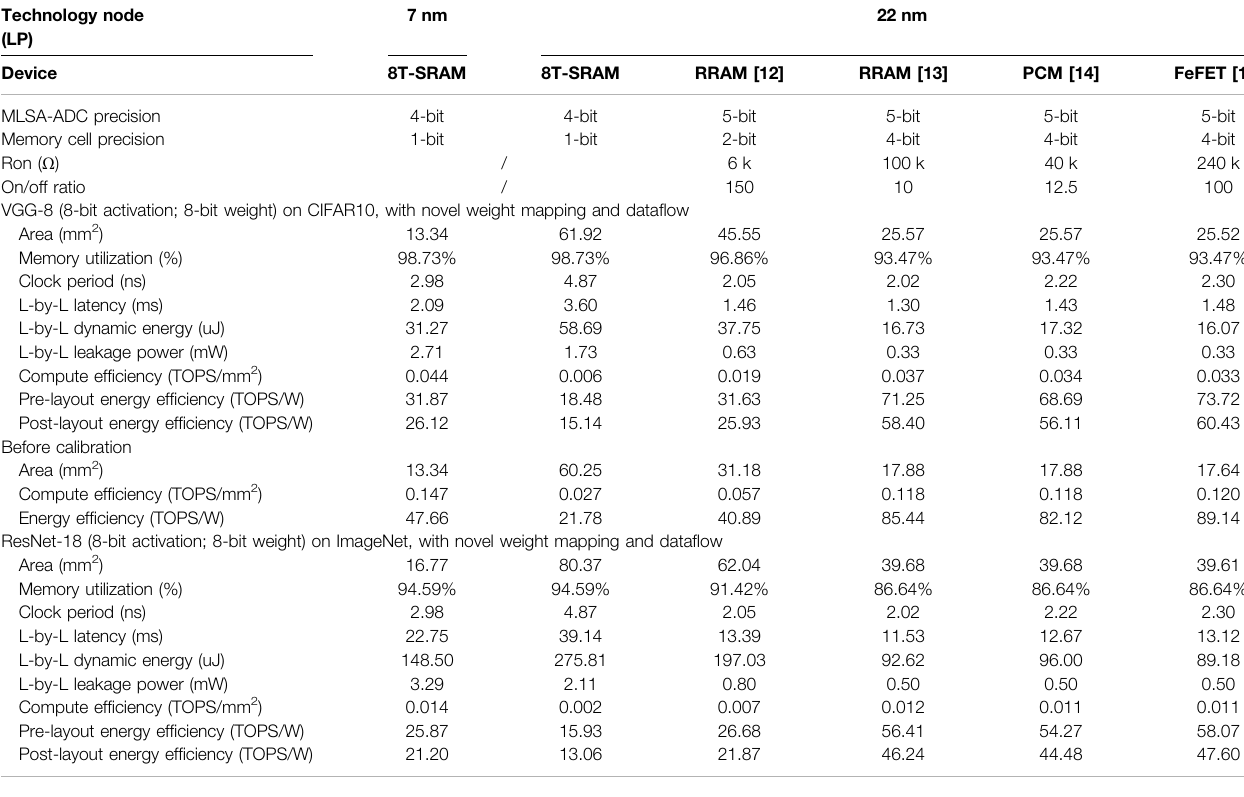
TABLE 7 | Benchmark results of CIM accelerators on VGG-8 for CIFAR-10 and ResNet-18 for ImageNet, based on SRAM (at 7 and 22 nm), and reported eNVM devices (assumed at 22 nm). Technology node (LP)